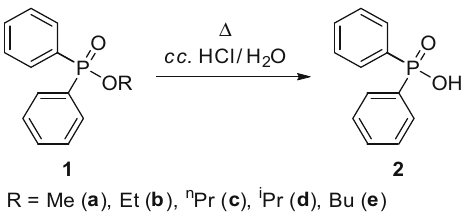
Scheme 2: Acidic hydrolysis of diphenylphosphinates on conven - tional heating.